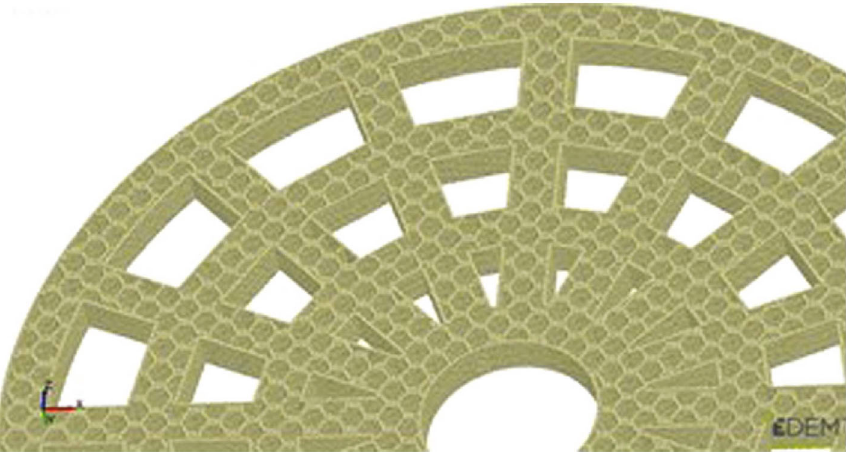
Figure 7: Discrete element model of three-dimensional spider web